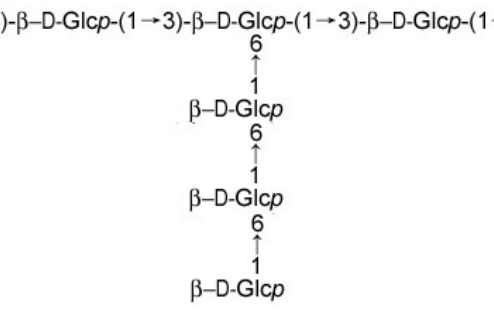
Figure 1. Schematic of the repeating unit of PRG.